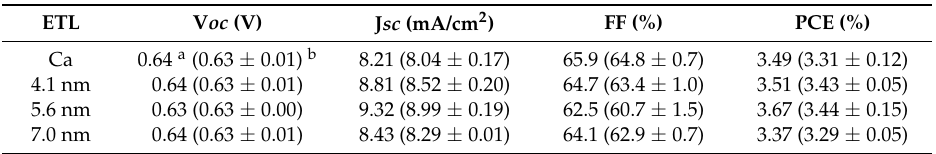
a Optimal device; b Average value obtained from six